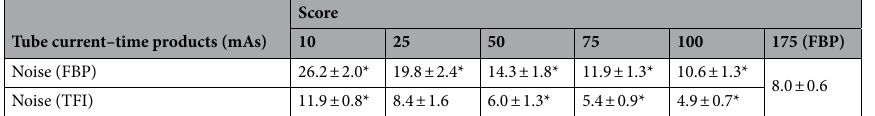
Table 6. Quantitative evaluation of noise on TFI and FBP: SD value. SD values are presented as mean ± SD. SD values of quantitative evaluation of noise were statistically analyzed using two-way ANOVA and the Bonferroni test as post-hoc test to compare the noise of FBP and TFI images at five different tube current–time products (10-, 25-, 50-, 75-, and 100-mAs) with the noise of 175-mAs-FBP images. *There was a significant difference compared to 175-mAs-FBP ( p <